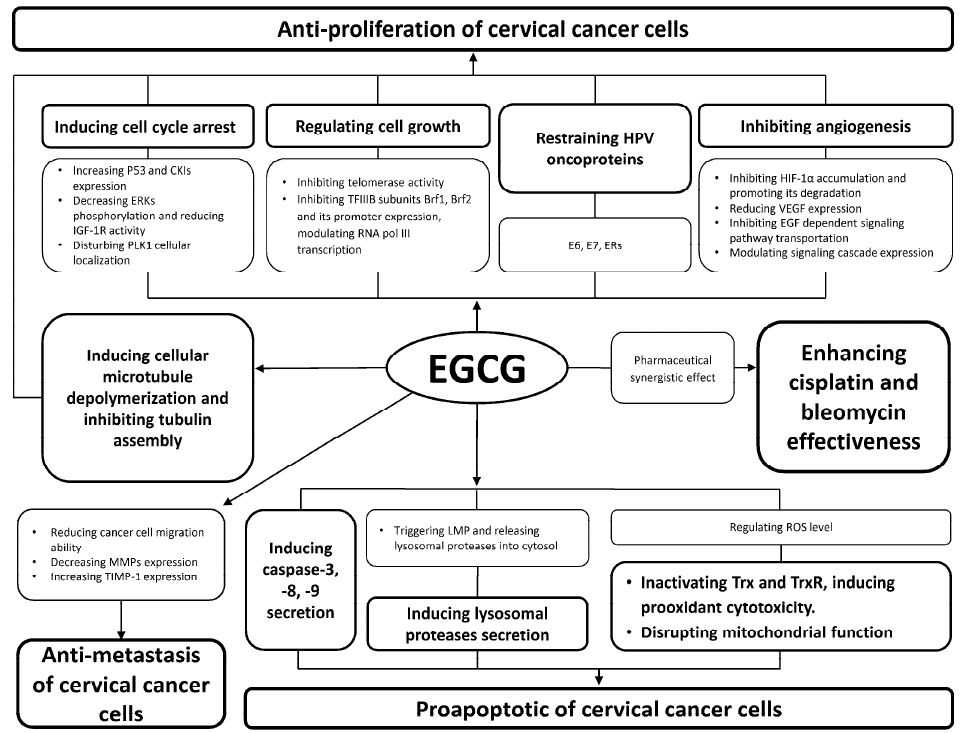
Figure 4. Overview of suppressive effects of EGCG on cervical cancer.